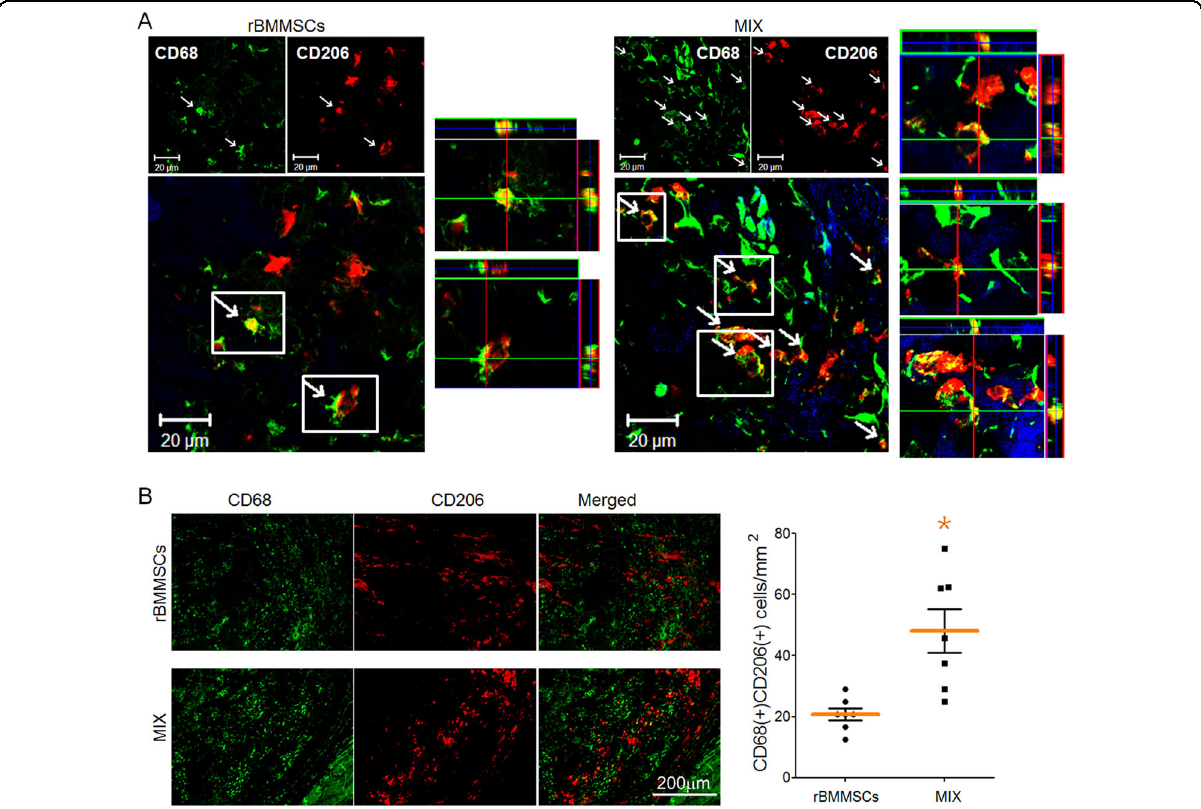
Fig. 5 Representative images showing that anti-in fl ammatory macrophages are more abundant in the MIX group than in the BMMSC group. a Anti-in fl ammatory macrophages were detected by double staining with the macrophage marker CD68 and the anti-in fl ammatory marker CD206 in confocal images. b The number of anti-in fl ammatory macrophages identi fi ed by double-positive staining for CD68 and CD206 was higher in the MIX group than in the rBMMSC